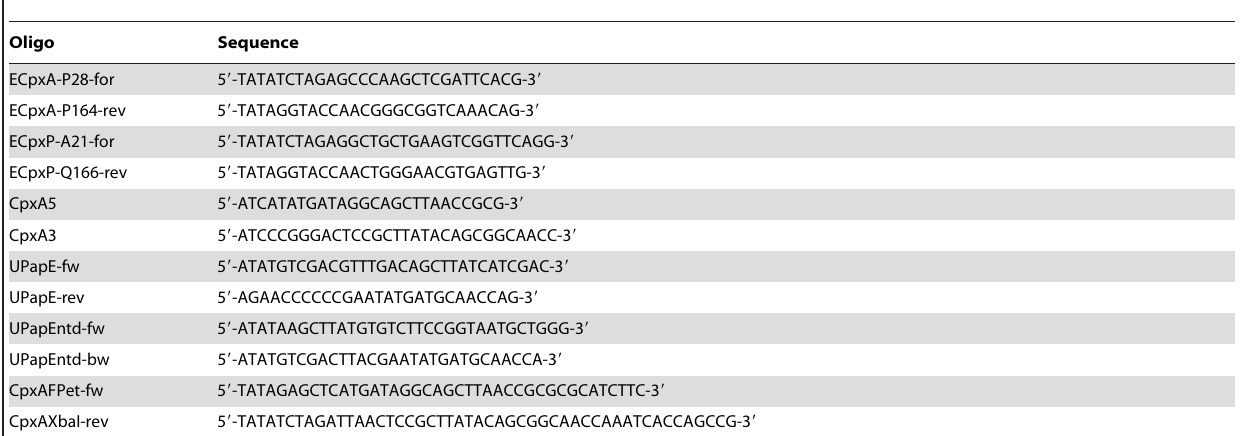
Table 2. Oligonucleotides used in this